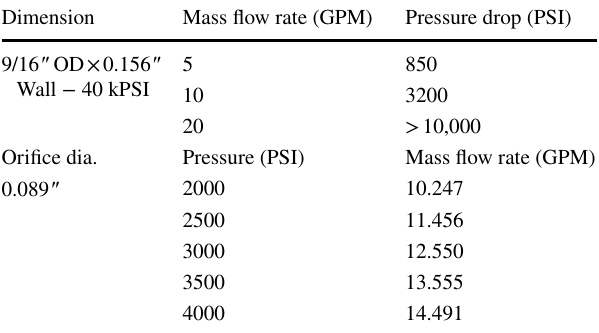
Fig. 2 Original and schematic diagram of the selected catalogue noz- zle (Gardner 2018) Table 2 Given catalogue performance analysis data (Gardner 2018)